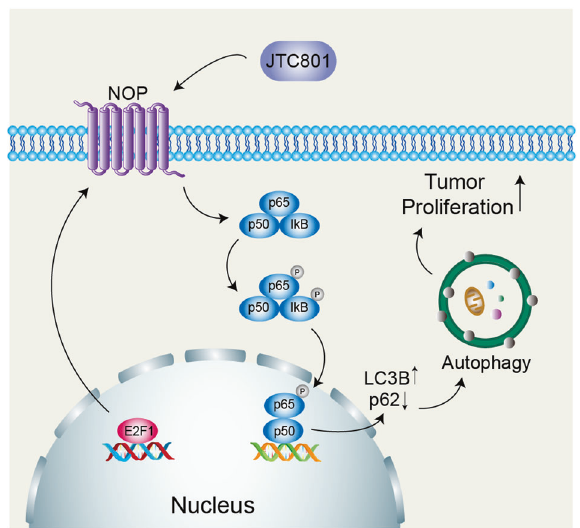
Fig. 7 Working model. Proposed model of the mechanism by which NOP activates NF-kB signaling to promote autophagy, which inhibits apoptosis in